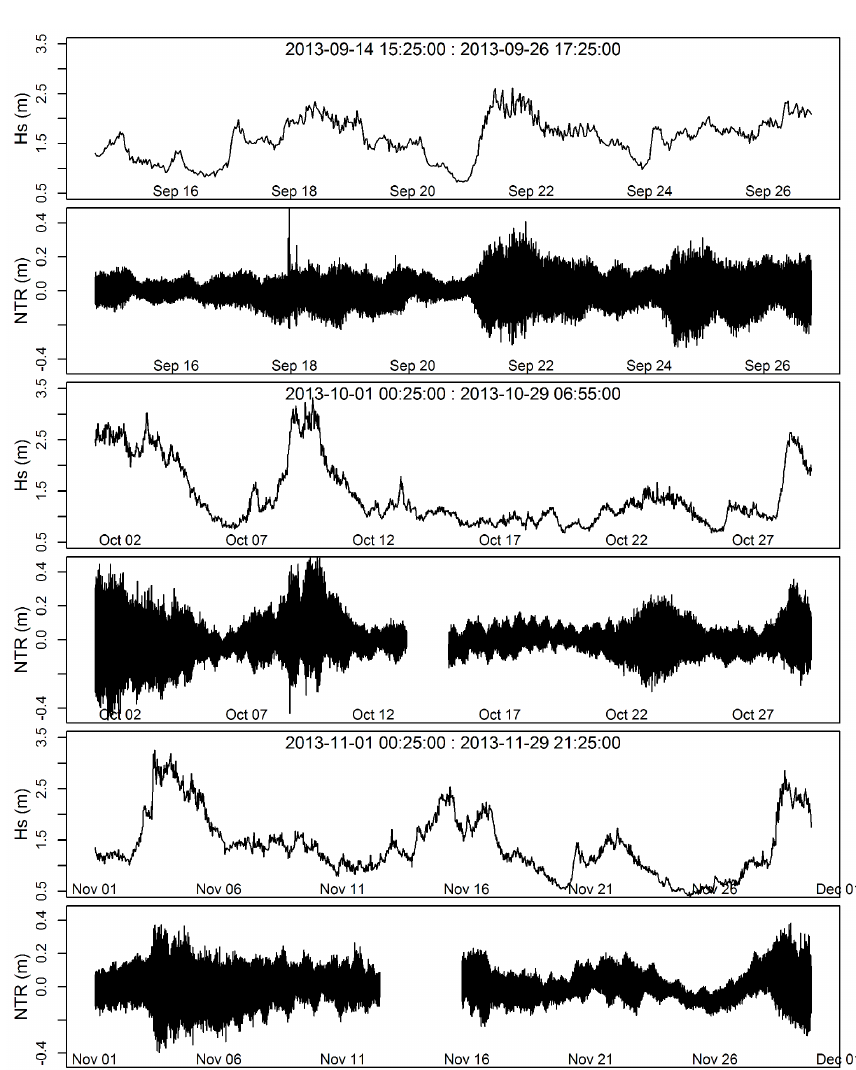
Figure 3. Significant wave height ( H s ) at the Monterey Canyon CDIP buoy (30min data) and 1Hz nontide residual water (NTR) levels from the NOAA tide gauge in Monterey